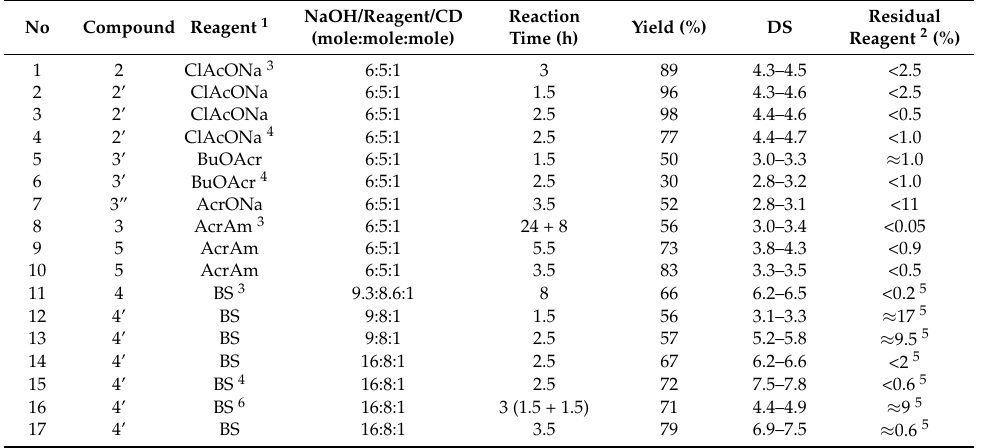
Table 1. Summary of solution and HEBM reactions (shaded lines are the solution reactions).